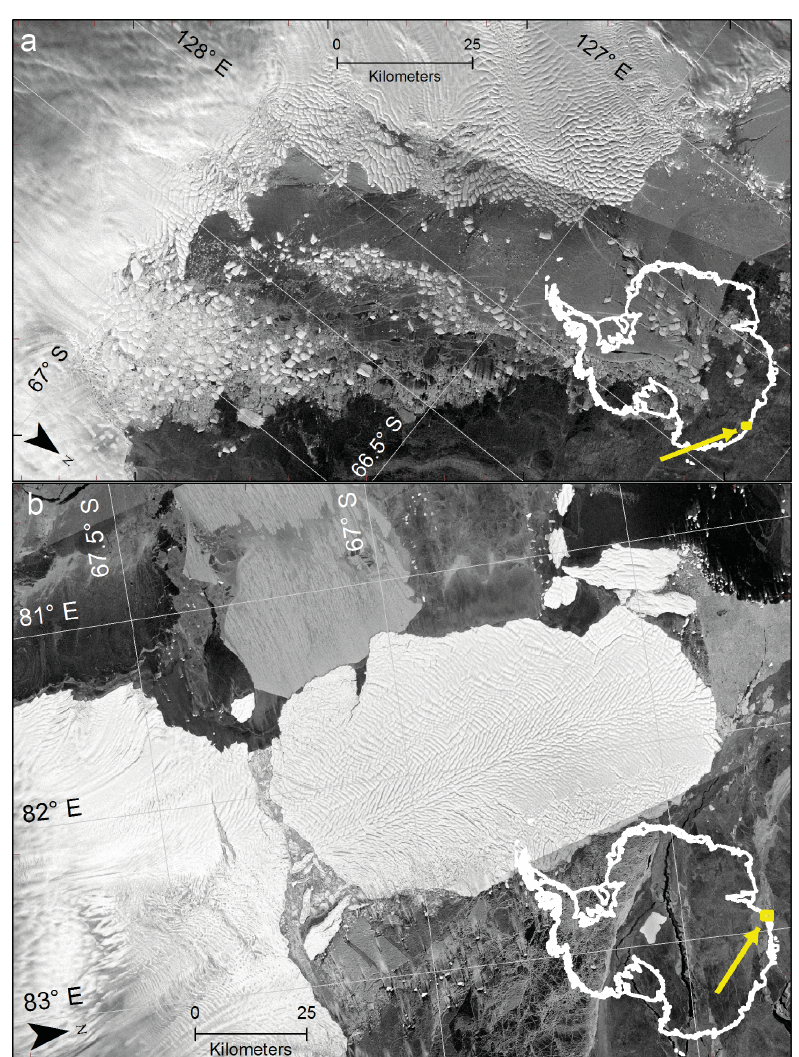
Figure 9. Two examples of iceberg calved from an IS pattern coastline. Image (a) shows a large number of small icebergs in front of the small ice shelves downstream the Holmes and the De Haven Glaciers and (b) shows the D15 iceberg in front of the West Ice Shelf. In the lower right of each image the location of this area (yellow rectangles) is indicated. The white lines in the inset images represent the coastline taken from RAMP AMM-1 (http://bprc.osu.edu/rsl/radarsat/data/) and the grounding line taken from Haran et al . [23]. Image courtesy: Byrd Polar Research Center &